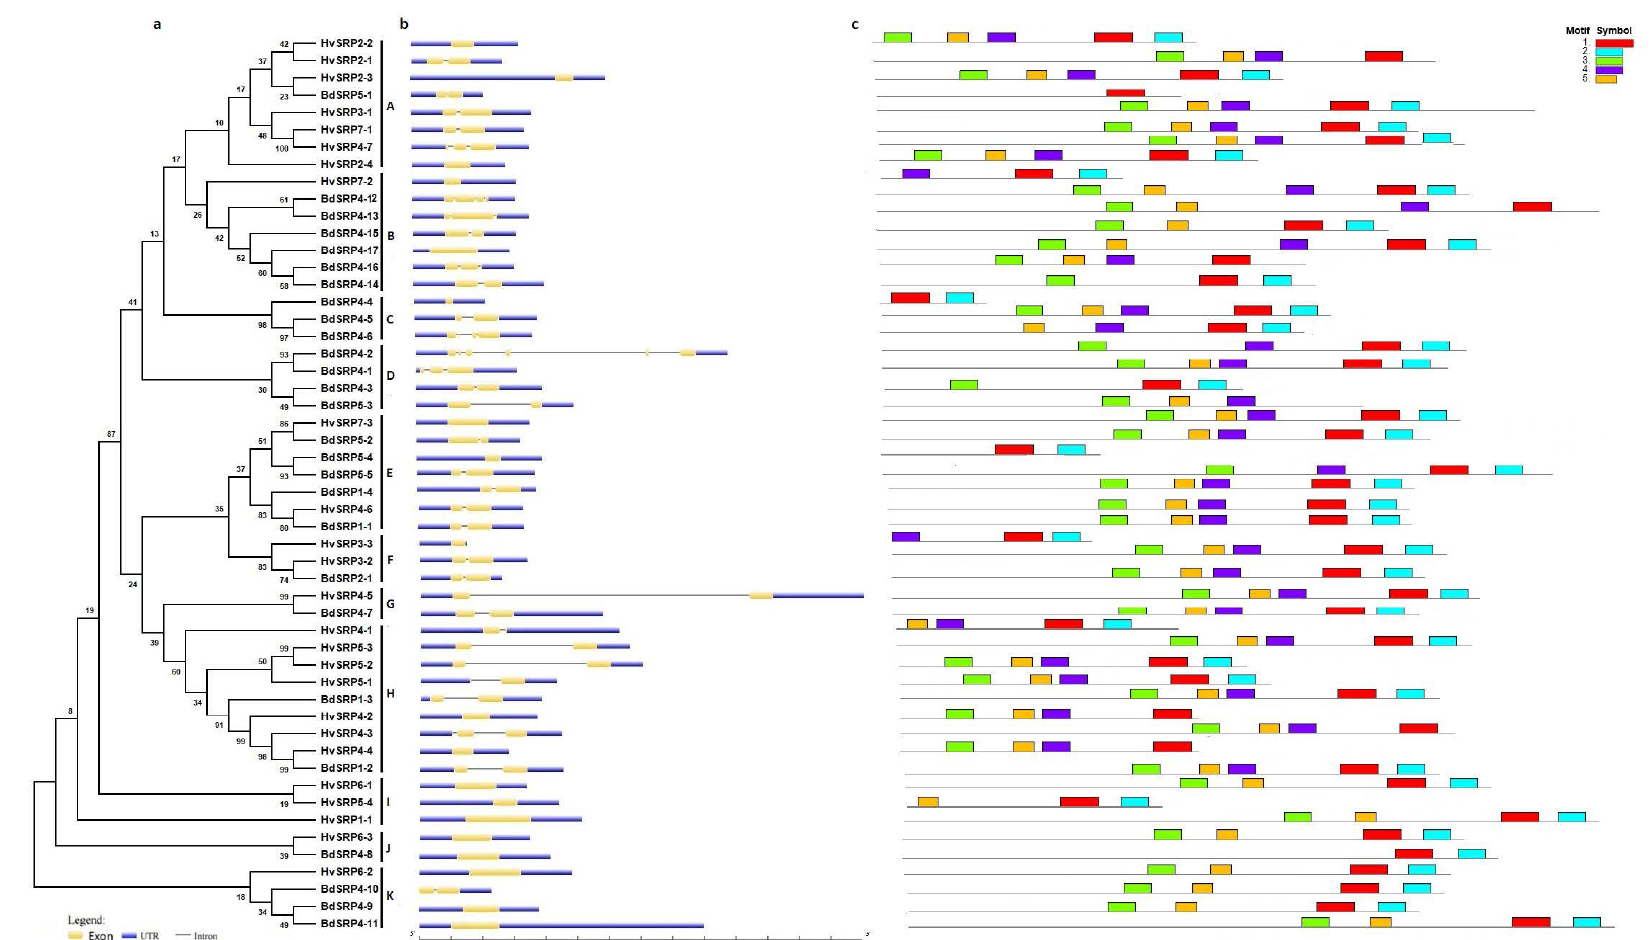
Figure 2. The phylogenetic relationships among serpin genes ( a ) and their exon / intron structures ( b ). The blue boxes represent the 5 (cid:48) -untranslated region (UTR) or the 3 (cid:48) -UTR, yellow boxes indicate exons and black lines exhibit introns. Conserved motifs in serpin proteins were identified using the MEME Suite program ( c ). The motifs are exhibited with specific colors. The tree was constructed with 1000 bootstrap replications using MEGA 6, based on the full-length protein